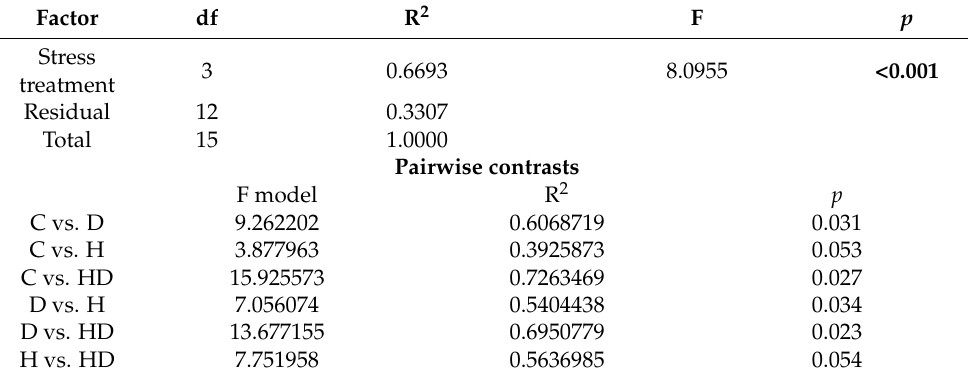
Table 5. Results of the PERMANOVA analysis testing the root morphology of maize plants against the stress treatment [Control (C), Drought (D), Heat (H) and Heat+Drought (HD)]. Factor df R 2 F p Stress 3 0.6693 8.0955 <0.001 treatment Residual 12 0.3307 Total 15 1.0000 Pairwise contrasts F model R